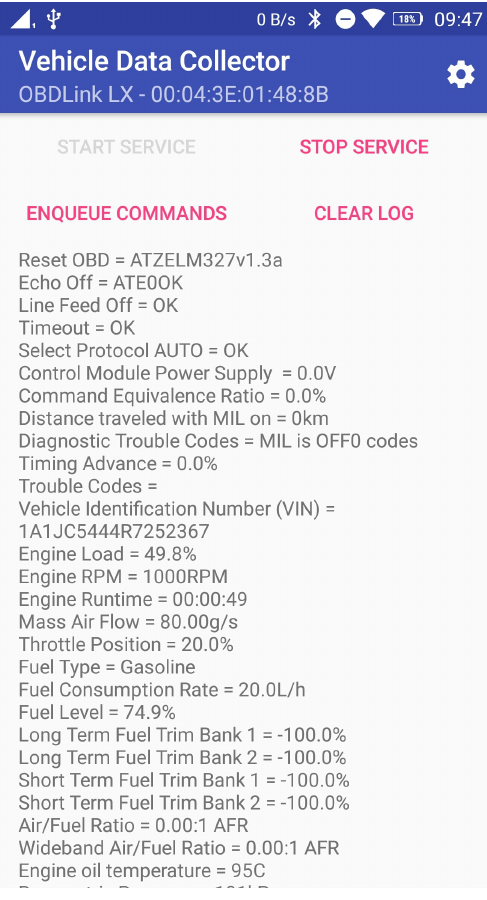
Figure 3. Example of the developed application presenting some retrieved